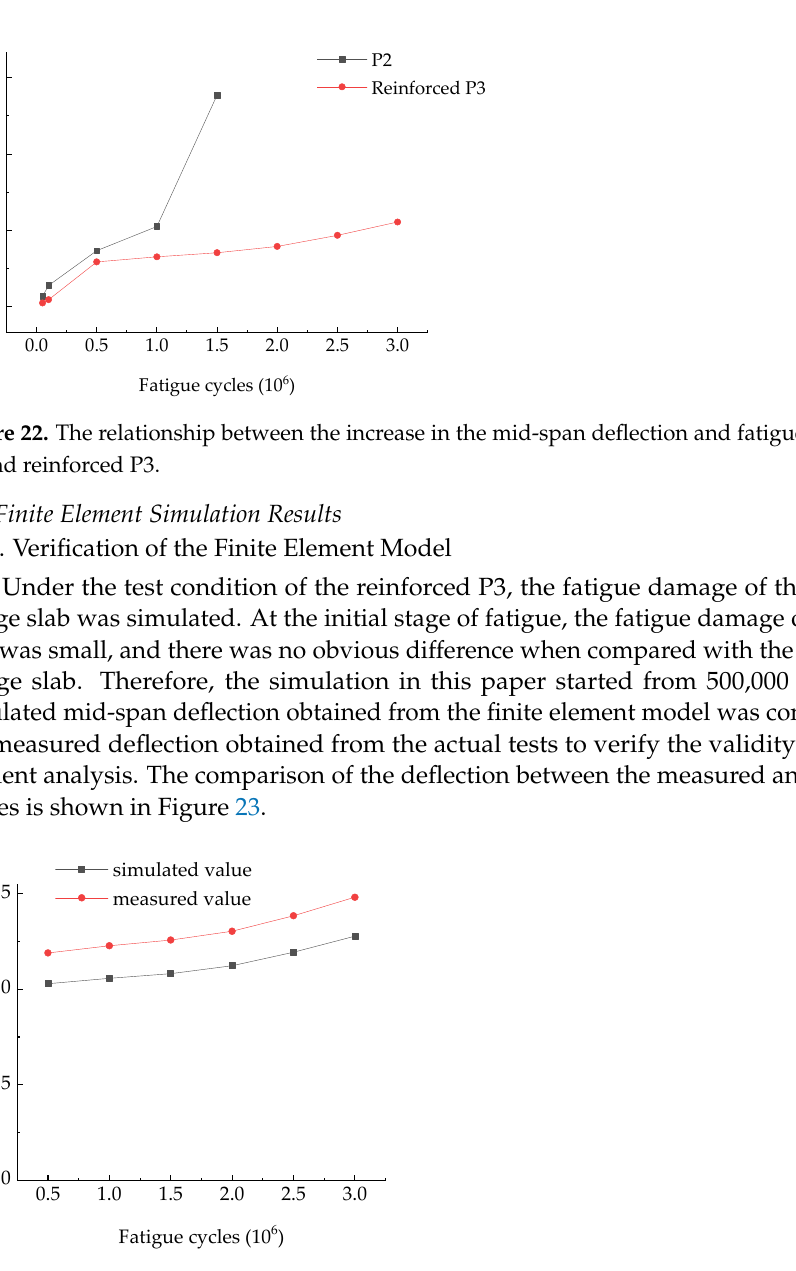
Figure 23. The comparison of the deflection between the measured and simulated values.